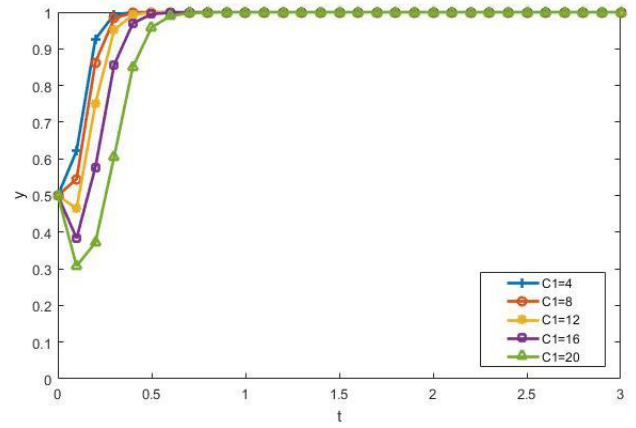
Figure 6. The impact of C 1 on the evolutionary results.